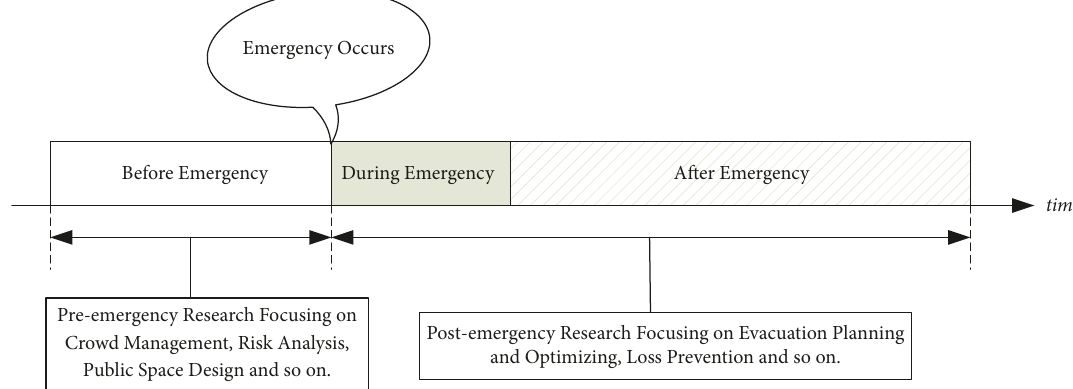
Figure 2: Definition of pre-emergency research and post-emergency